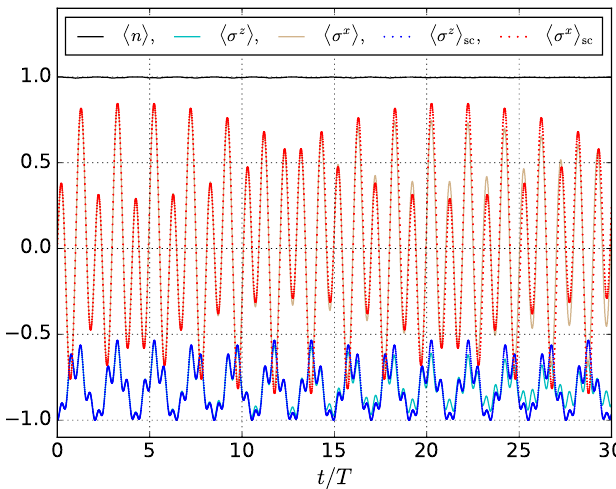
Figure 3: Emergent effective periodically driven dynamics in the semi-classical limit of the quantised light-atom interaction. The solid lines represent expectation values in the spin- photon basis, while dashed lines – the corresponding semi-classical quantities. The parameters are A / ∆ = 1, Ω / ∆ = 3.5. The photon Hilbert space has a total number of N and the mean number of photons in the initial coherent state is N